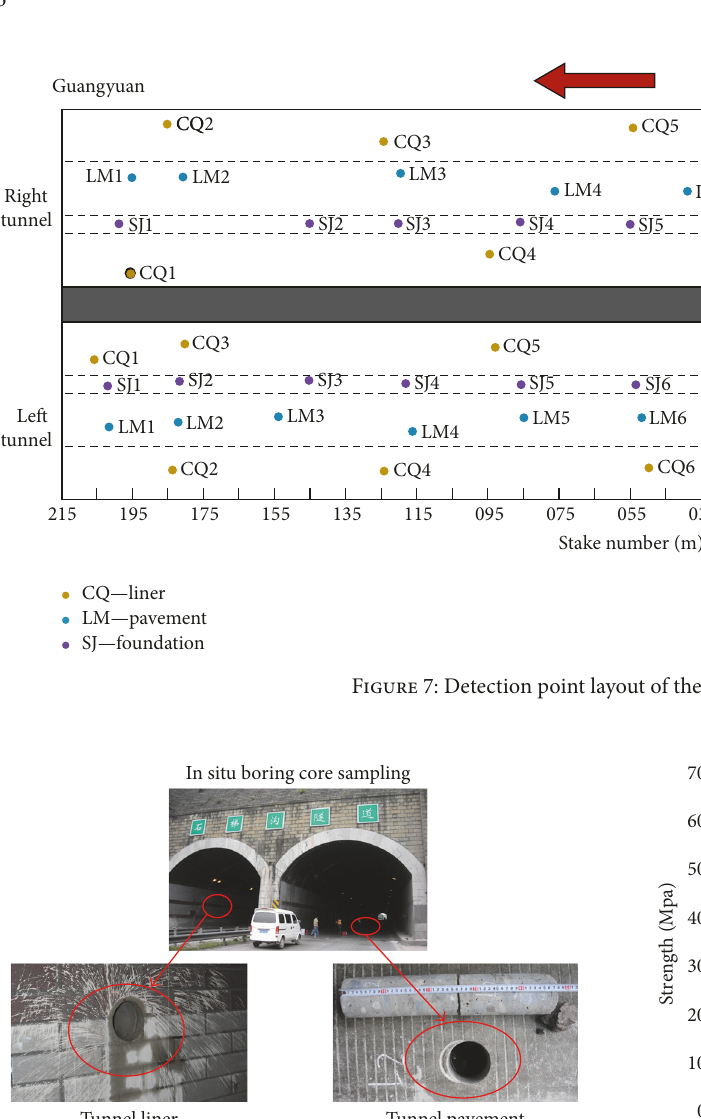
Figure 8: Boring core sampling on the tunnel structure.